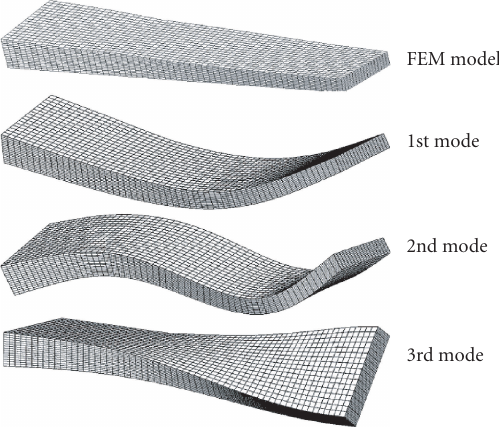
Figure 2: FEM model and vibration modes of specimen B1.